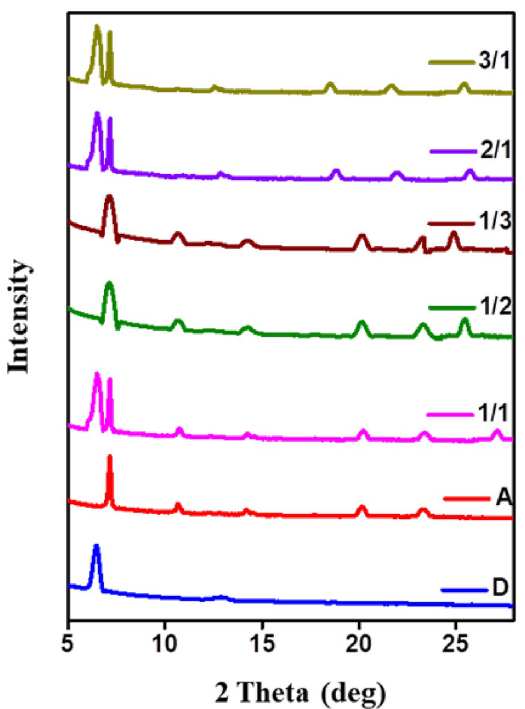
Figure 5. Thin film XRD patterns of D,A and D/A blends, Graph was plotted using Origin software (https :// www.origi nlab.com/, version: